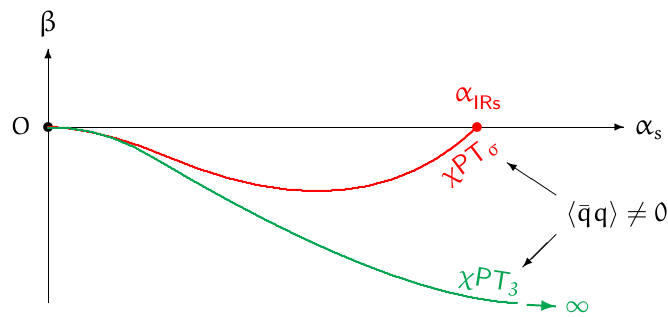
Figure 1. Alternatives for the N f = 3 QCD β -function. (A) Conventional N f = 3 soft-meson theory 1 ∞ to ensure that heavy hadrons χ PT 3 (green curve) involves a large breaking of scale invariance at α s ∼ such as nucleons acquire sufficient mass, but then that mechanism also generates the mass of the f 0 , m K m N . (B) That problem is solved in χ PT σ (red curve): (a) the massless which is not heavy: m f 0 ∼ (cid:28) dilaton σ at α IR s allows nucleons to be heavy (Equation (2)), and (b) σ becomes the pseudodilaton f o as it acquires a small (mass) 2 to first order in (cid:101) s = α IR s α s . Both curves are consistent with − model-independent U χ PT.